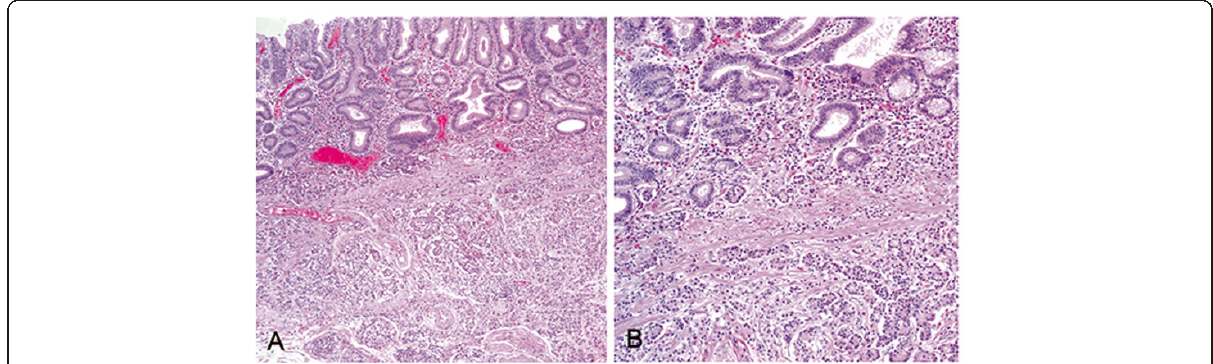
Figure 1 Neuroendocrine tumor with an organoid growth pattern infiltrating into the submucosa within a tubular adenoma (A). Higher magnification showing small tumor cells in the deeper part of mucosa and submucosa ( B ).